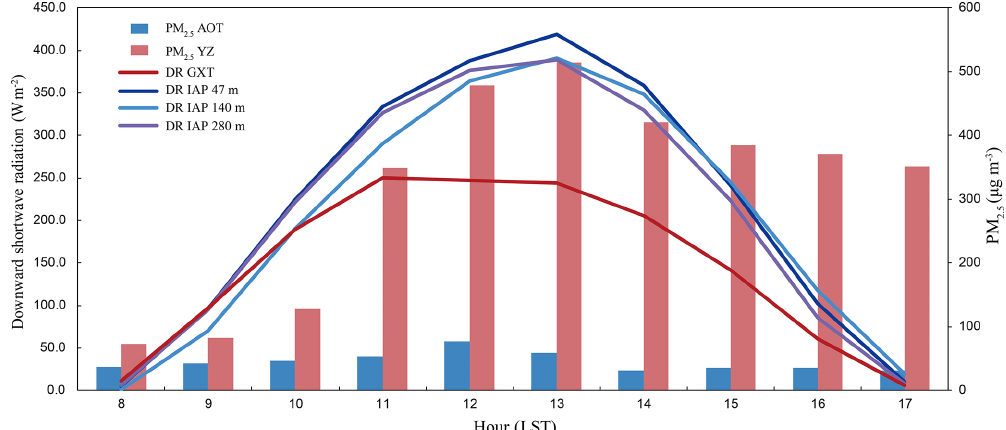
Figure 11. The temporal variations of PM 2 . 5 concentrations at AOT (blue bars) and YZ (red bars), and downward shortwave radiation at GXT and at heights of 47, 140 and 280m on the IAP tower during daytime on 24 December 2015.